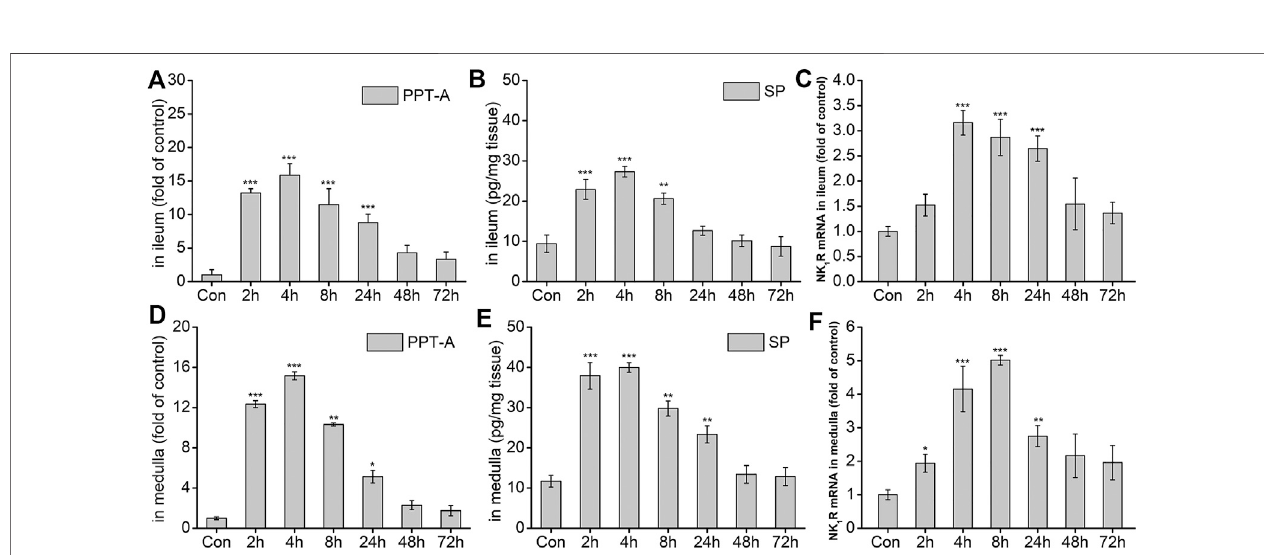
FIGURE 6 | The effect of DAS on PPT-A mRNA, SP secretion, and NK1 receptor (NK1R) mRNA levels in the ileum and medulla of rats. Rats were received DAS (2 mg/kg,p.o.),andtheirileumandmedullawerecollectedat2,4,8,24,48,and72 haftertreatment(A,B,andC-ileum;D,E,andF-medulla). PPT-A and NK 1 R mRNA levelswere detected using quantitative real-time PCR.S p concentrationwasdetectedusing acommercial assaykit. Thedataareexpressed asmean ± SEM.Statistical signi fi cance was assessed using the one-way ANOVA. * p < 0.05, ** p < 0.01, *** p < 0.001 vs. control the group.